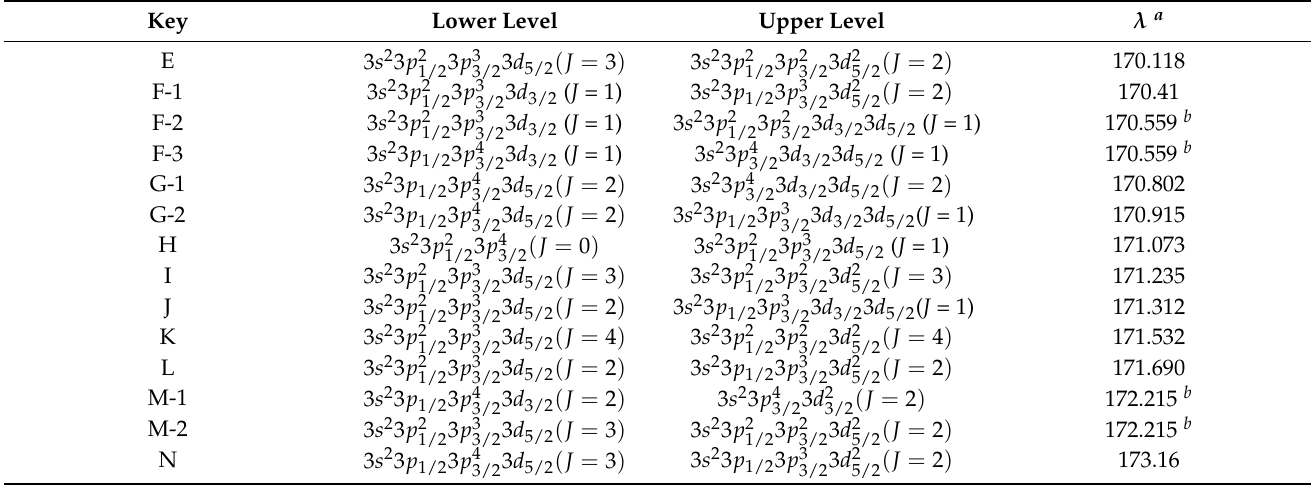
Table 1. Iron Fe IX lines observed in EBIT-I measurements. Wavelengths are in